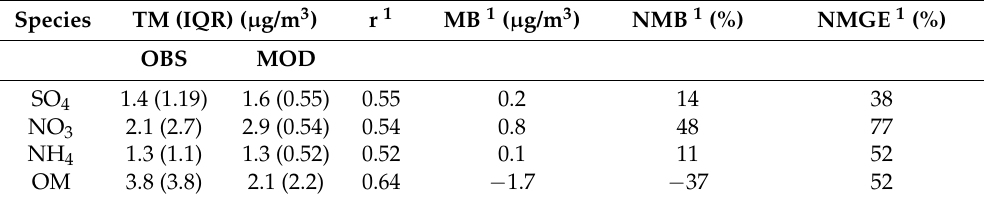
Figure 3. Comparison of observed (black) and modelled (red) time series of daily trimean of mass concentrations of ( a ) SO 4 , ( b ) NO 3 , ( c ) NH 3 , and ( d ) OM, at Cabauw supersite. The black shaded area and red bars represent the observed and predicted 25th and 75th percentiles, respectively. Table 3. Trimean values (TM), interquantile range (IQR), correlation coefficient (r), mean bias (MB), normalized mean bias (NMB), and normalized mean gross error (NMGE) from the comparison between observed and modelled aerosol sulfate (SO 4 ), aerosol nitrate (NO 3 ), aerosol ammonium (NH 4 ), and organic matter (OM).